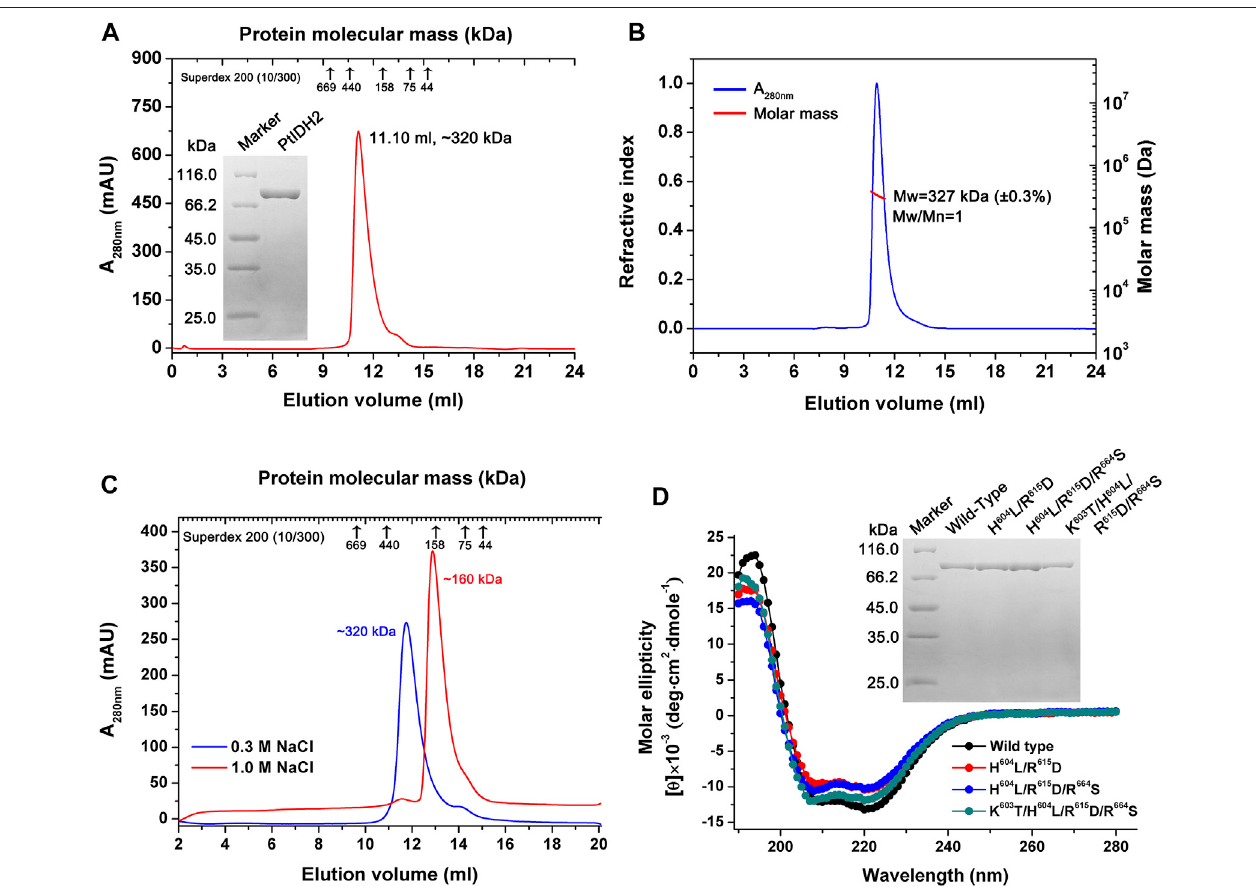
FIGURE 3 | Overexpression and puri fi cation of PtIDH2 and its mutant forms. (A) Overexpression and puri fi cation of wild-type PtIDH2. Size-exclusion chromatography (SEC)elutionpro fi leofPtIDH2obtainedusingaSuperdex200(10/300)columnata fl owrateof0.5 ml/min.Theleftinsetpanelshowstheproteinpurity detection by 12% SDS – PAGE. (B) SEC with multiangle light scattering (SEC – MALS) analysis of wild-type PtIDH2. The molar mass and refractive index were plotted vs. the elution volume from a Superdex 200 (10/300) column with a fl ow rate of 0.5 ml/min. (C) SEC elution pro fi les of PtIDH2 performed with Superdex 200 (10/300) column. The column was equilibrated with a buffer (20 mM Tris-HCl, 10% Glycerol, pH 7.5) containing 0.3 M or 1.0 M NaCl, respectively. PtIDH2 samples were also incubated inthatbufferbeforechromatography. (D) Circulardichroismspectraofwild-typePtIDH2and three mutants. Therightinsetpanel showsthewild-type PtIDH2 and three mutants purity detection by 12% SDS –